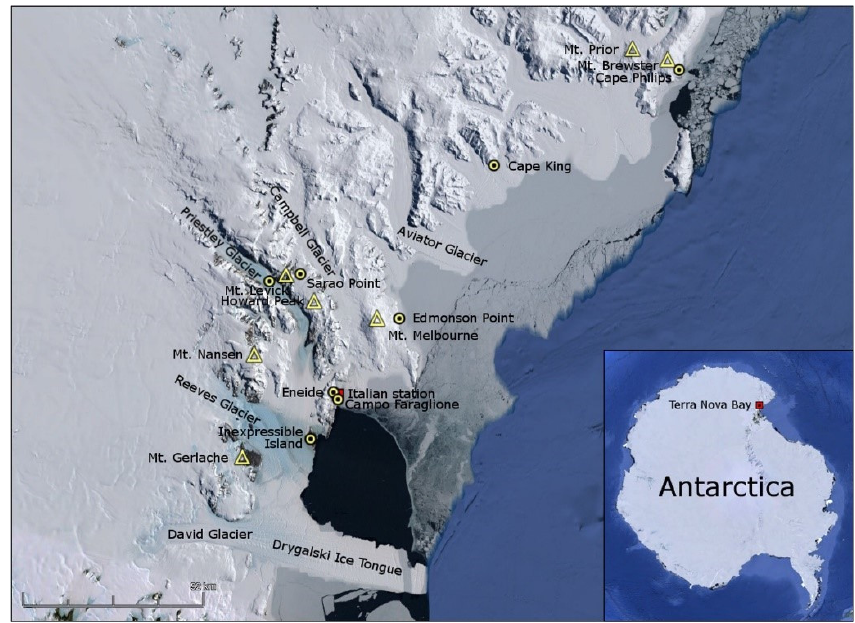
Figure 1. Satellite map of the Victoria Land, showing the position of the Italian Antarctic Station (MZS in the text) and the sampling sites. (MZS in the text) and the sampling